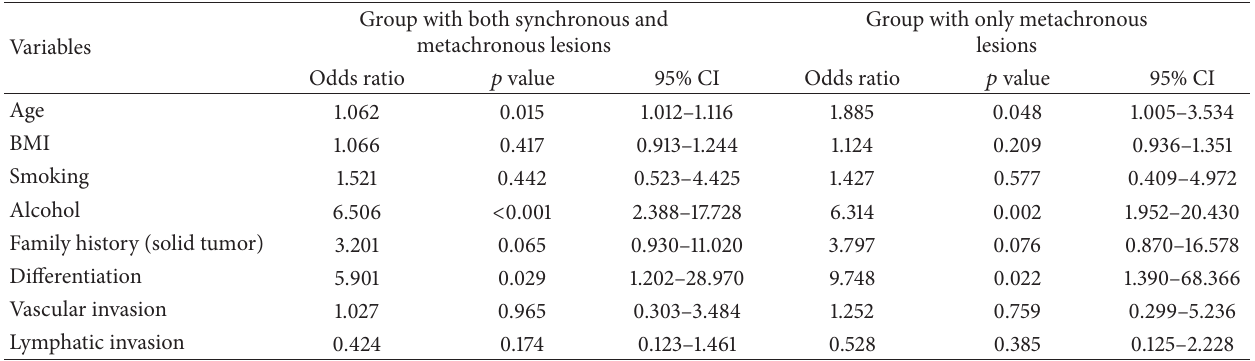
Table 2: Multivariate analysis for the clinicopathologic factors associated with gastric adenoma or gastric cancer in colorectal cancer